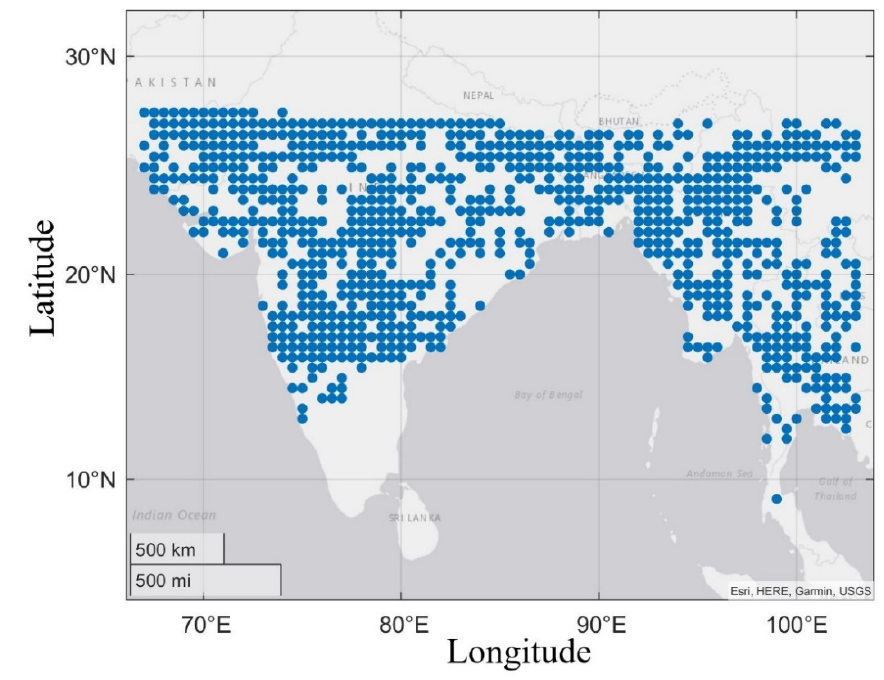
Figure 1. Latitude and longitude of the selected data (clear sky). Table 1. FY-4A/GIIRS instrument performance